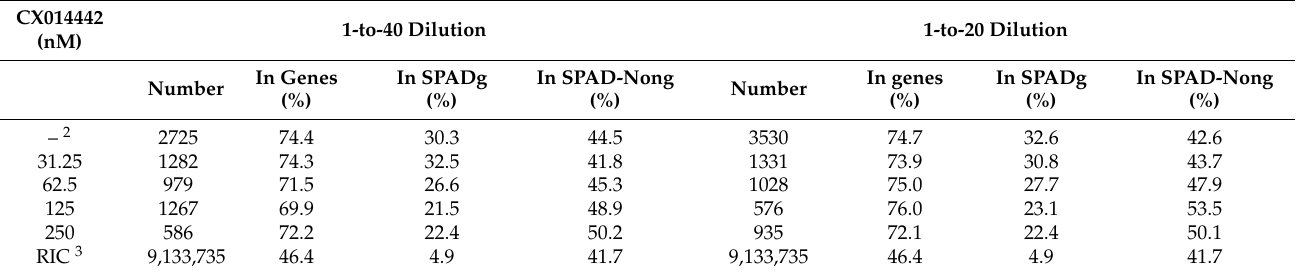
Table 3. Integration sites derived from CX014442-treated virions 1